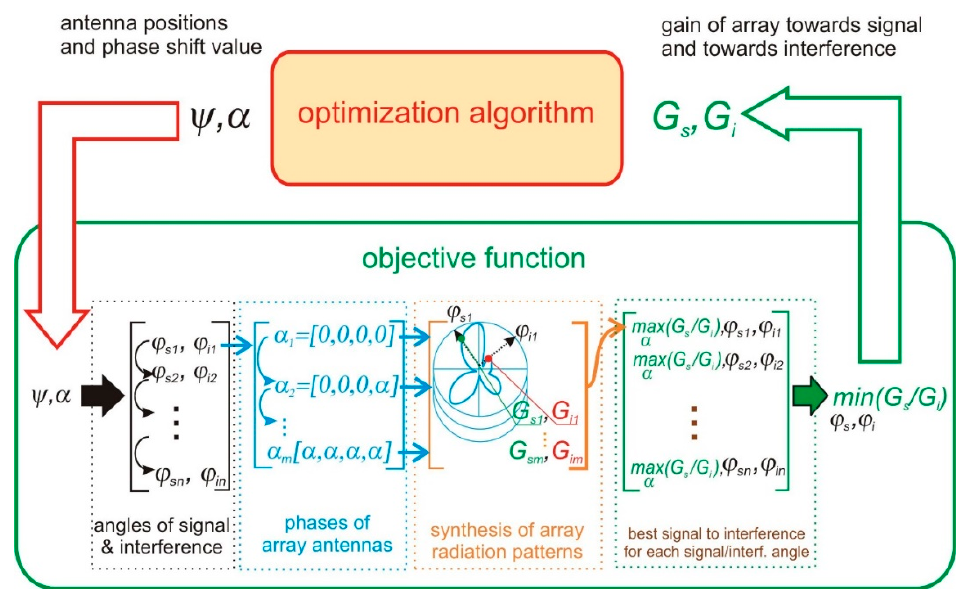
Figure 8. Optimization loop flow-chart showing the algorithm for the calculation of objective function components.